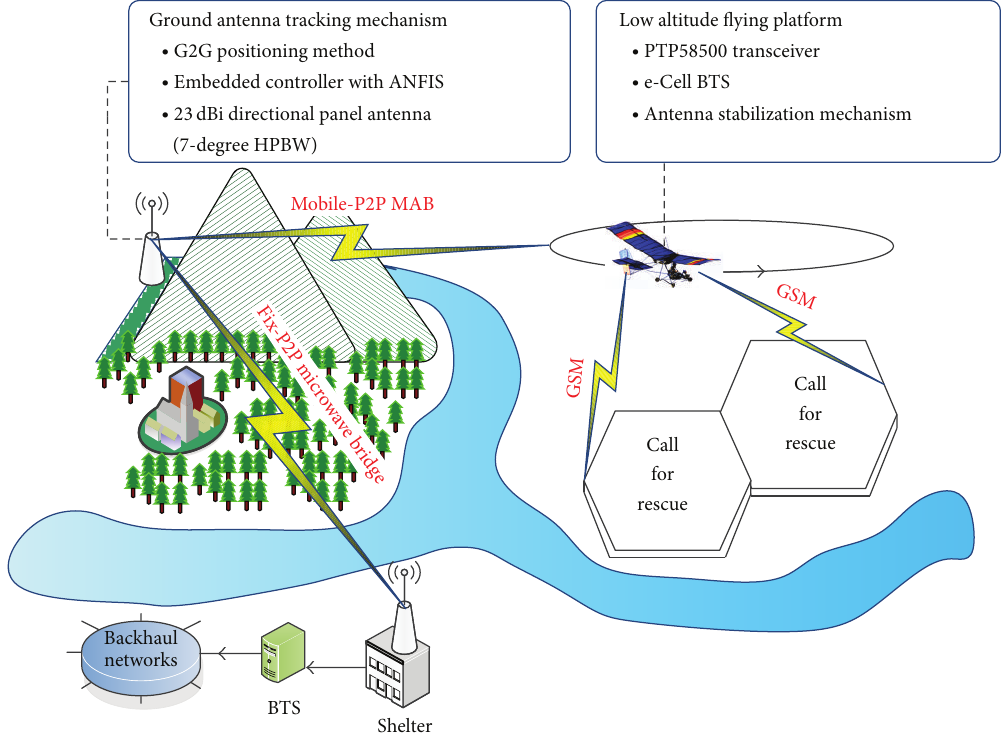
Figure 1: The proposed Sky-Net mobile signal relaying